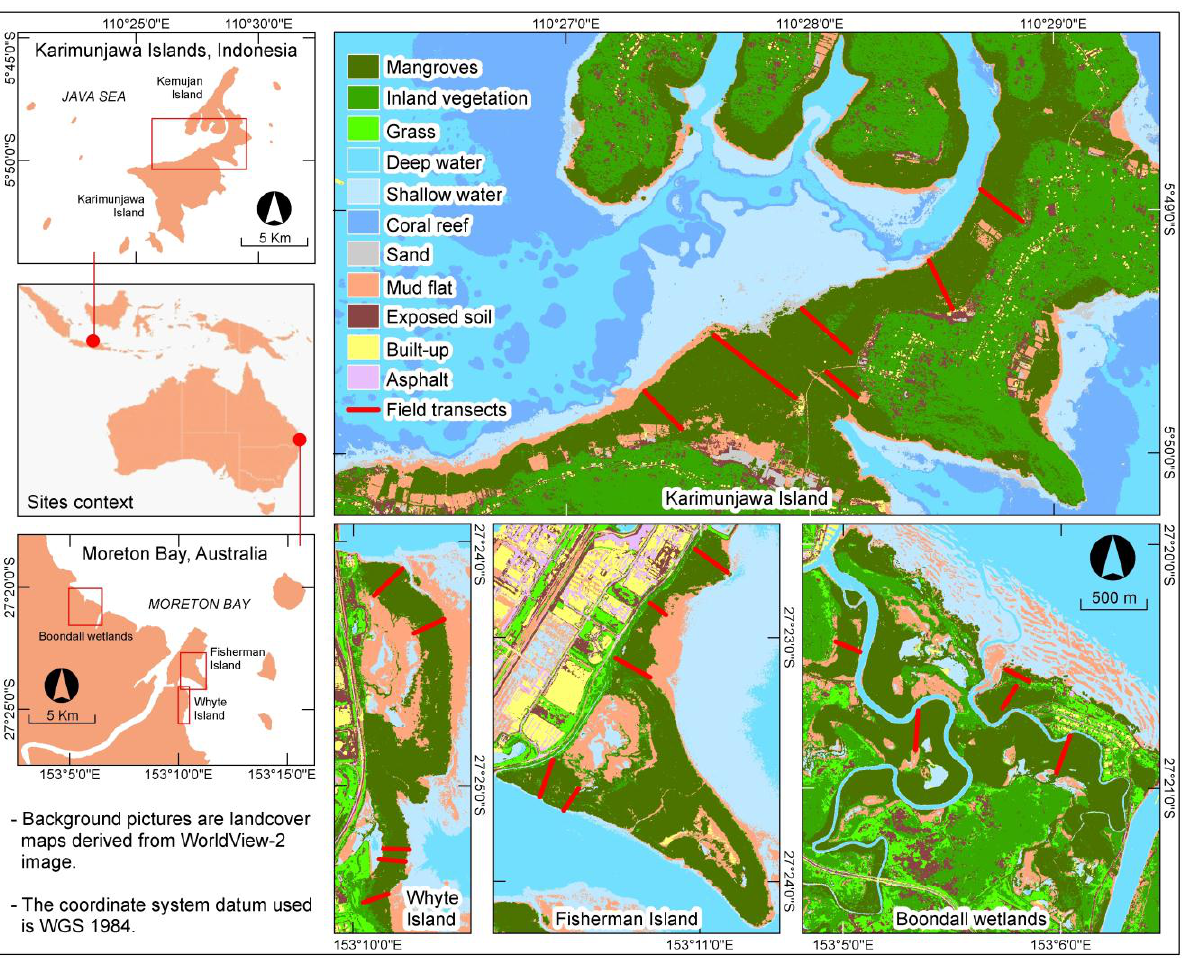
Figure 2. Study sites showing the major land-cover types and the field transects across the mangrove